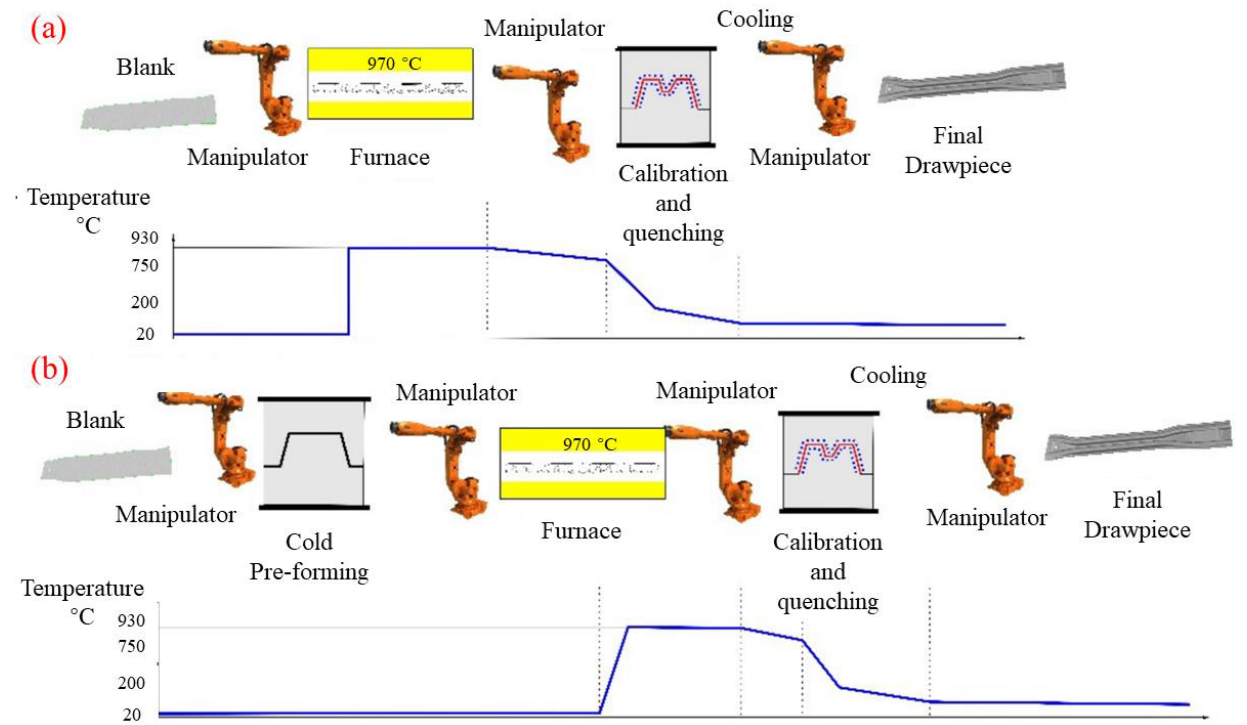
Figure 6. Scheme of the hot stamping process: ( a ) direct hot stamping and ( b ) indirect hot stamping [26].